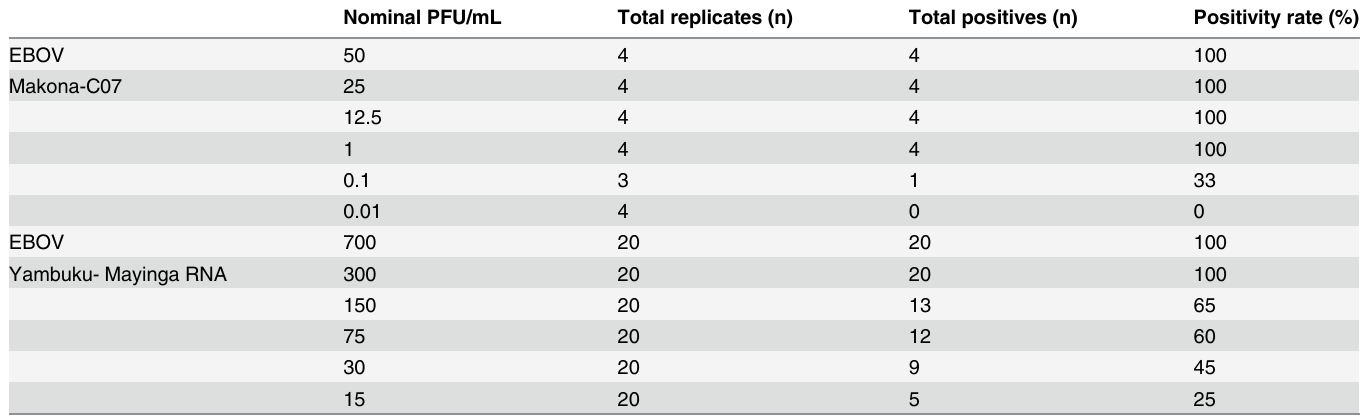
Table 4. Numbers of positive replicates per level in the Xpert 1 Ebola Assay for EBOV Makona-C07, and for EBOV Yambuku-Mayinga RNA, both in EDTA-whole